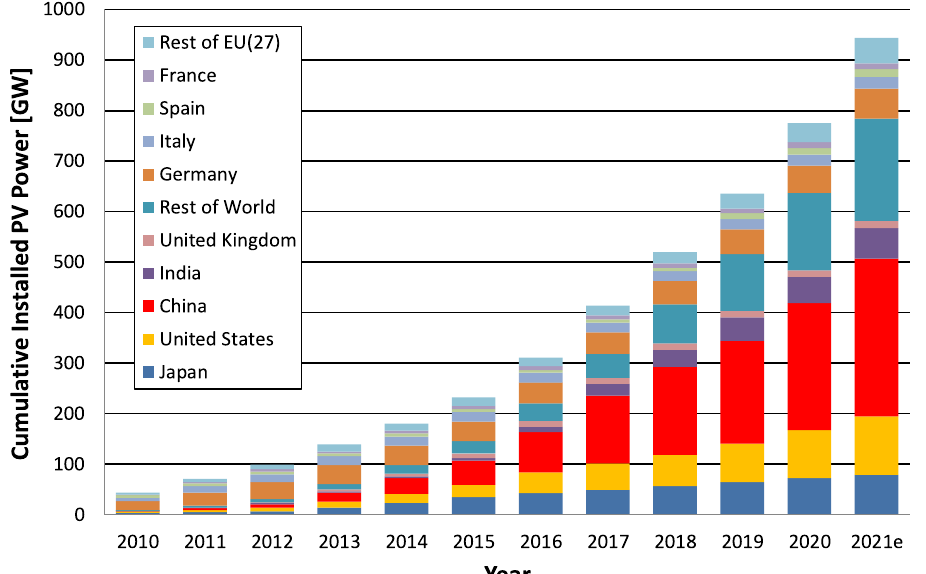
Fig. 3. Cumulative photovoltaic installations from 2010 to 2020 with estimate for 2021 (data source: [18 – 21] and own